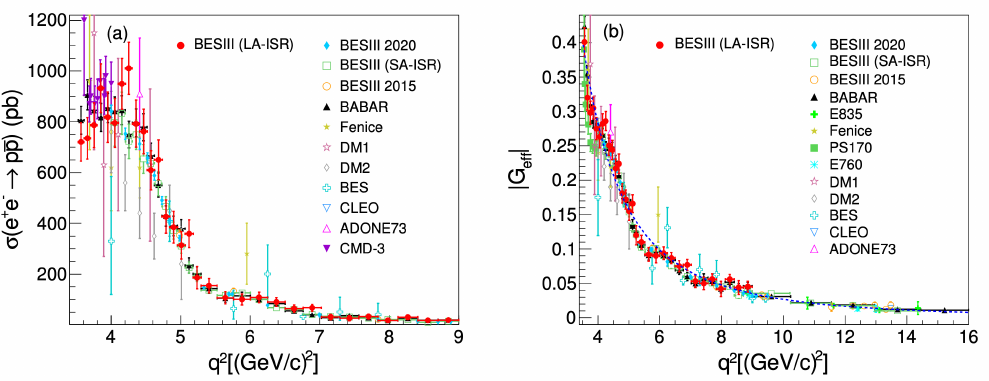
Figure 3: BESIII results for the cross section of the process e + e − → pp and the effec- tive FF of the proton [ 8 ] .